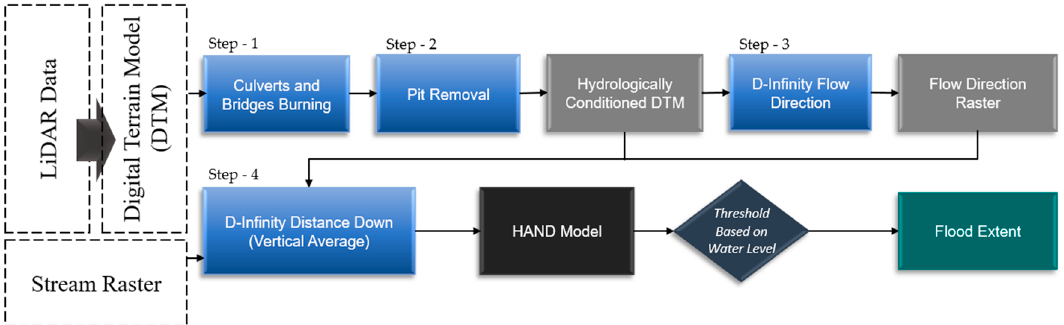
Figure 5. Implemented workflow for generating flood extents from the height above nearest drainage (HAND) model.